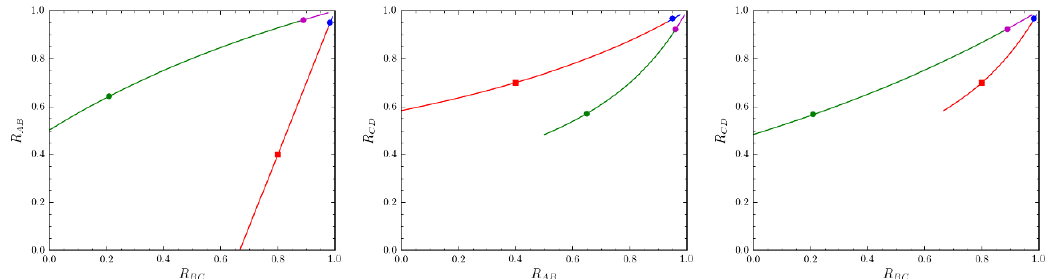
Figure 3 . The two trajectories in mass parameter space leading to the same endpoints a , b and c . The lines are colored in accordance with the coloring convention for the regions depicted in (cid:12)gure 2. The red square marks the original study point P 31 from table 1, while the circles denote the other three study points from table 1: P 41 in region (4 ; 1) (blue circle), P 43 in region (4 ; 3) (magenta circle), and P 23 in region (2 ; 3) (green circle).